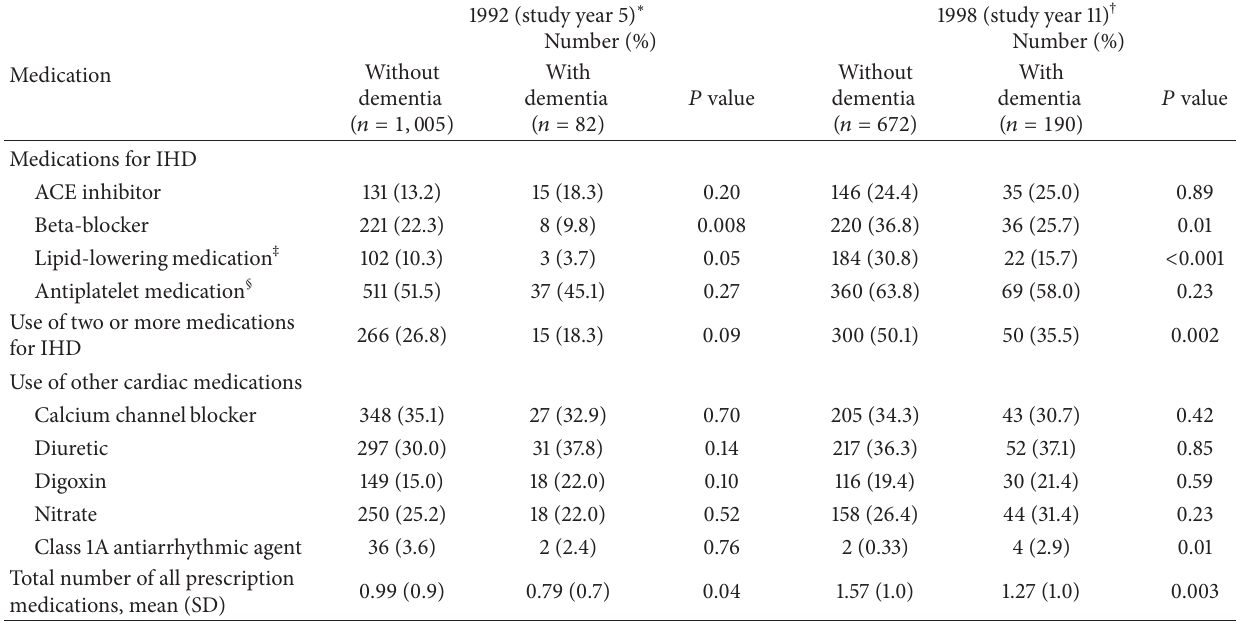
Table 2: Unadjusted use of guideline-recommended medications by study participants in 1992 and 1998, stratified by dementia status.